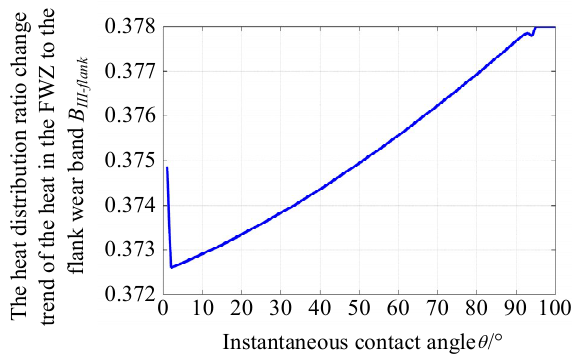
Figure 23. Heat distribution ratio of the heat source in the FWZ to the wear band on the flank of end mills.